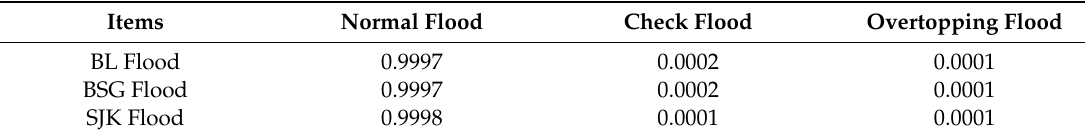
Table 2. The prior probability of each dam flood node.